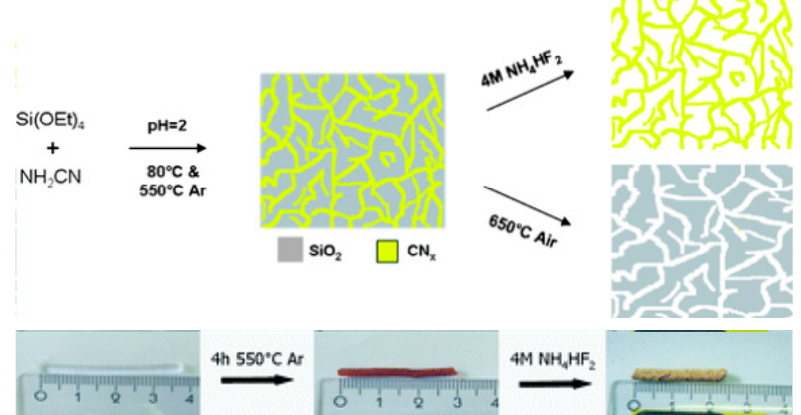
Figure 22. Schematic illustration indicating the synthesis process of porous carbon nitride and silica aerogels based on the sol-gel method and the digital photos of corresponding aerogels. Adapted with permission from Reference [120]. Copyright (2011) Royal Society of Chemistry.